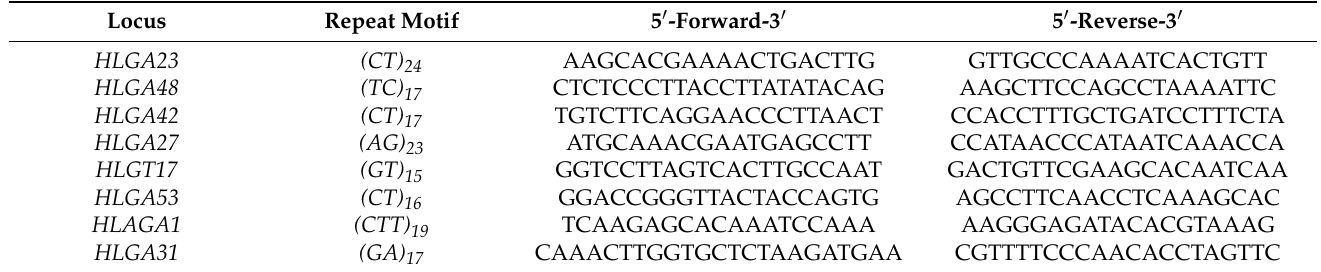
Table 2. List of SSR loci used in the present